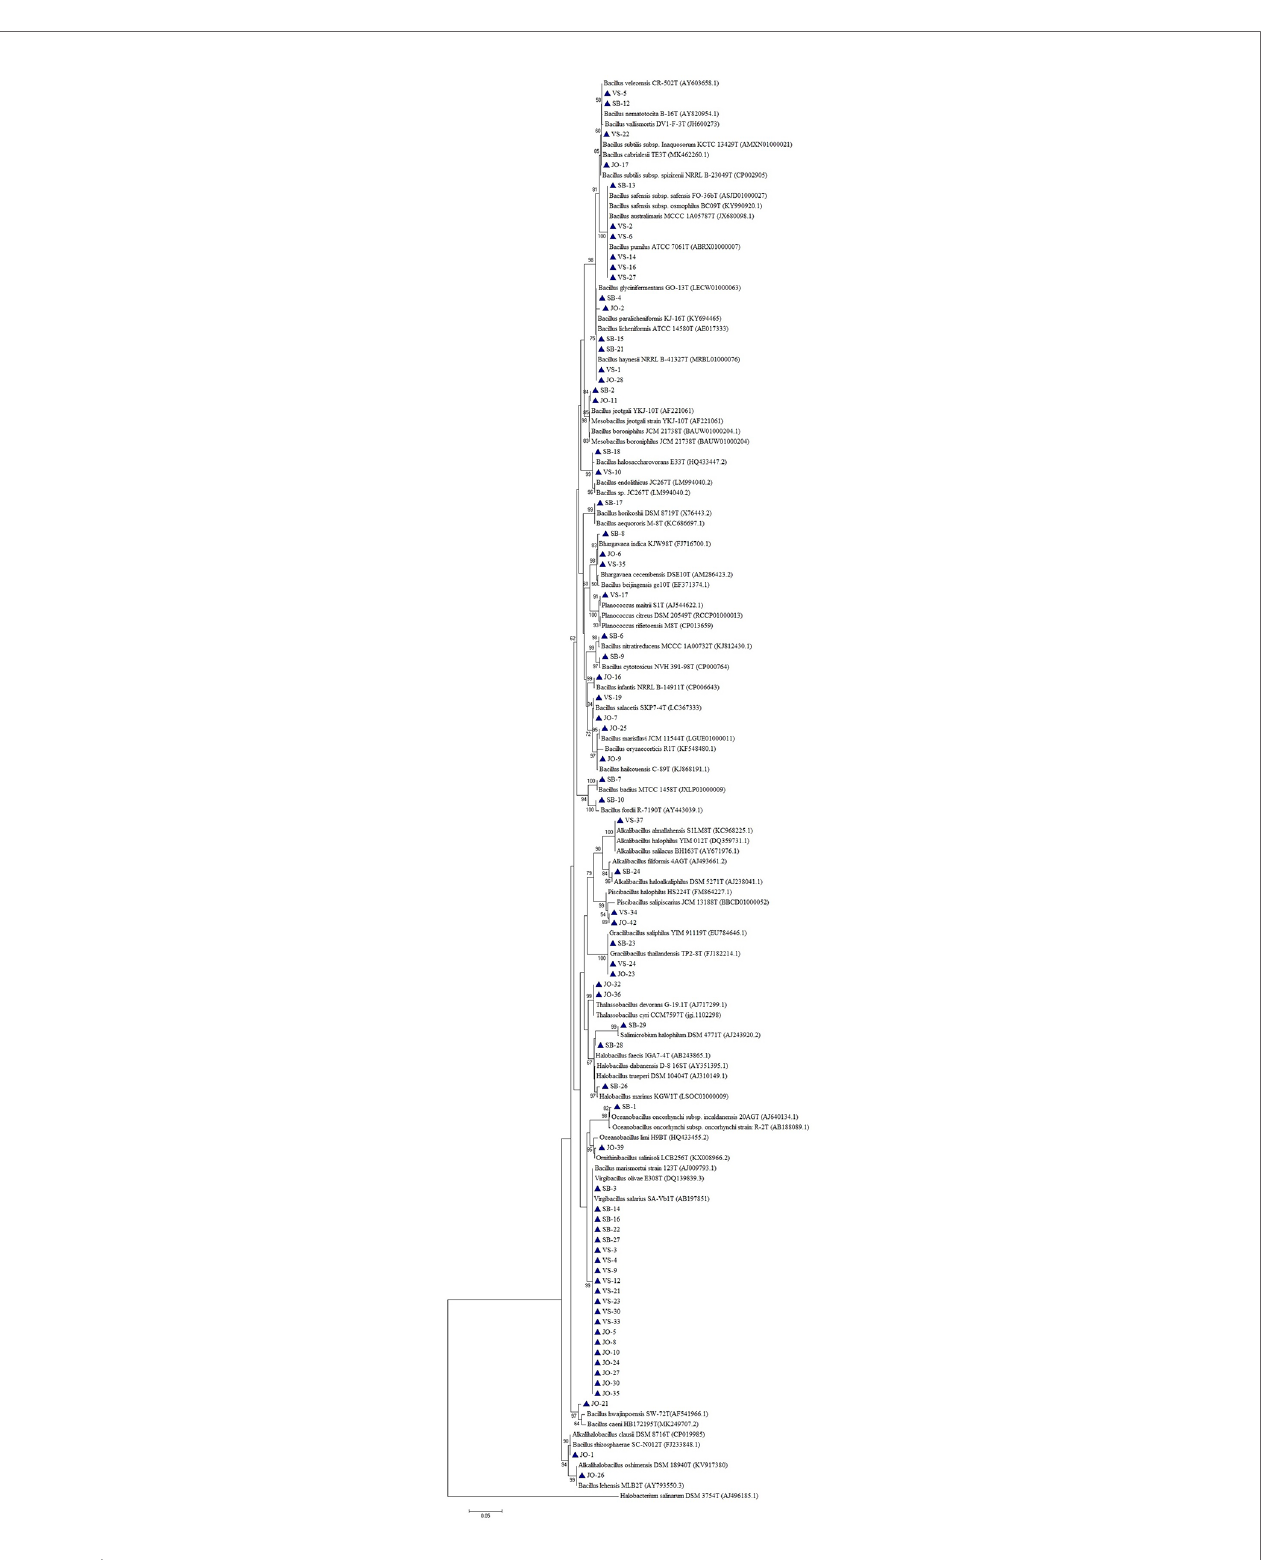
Frontiers in Marine Science |